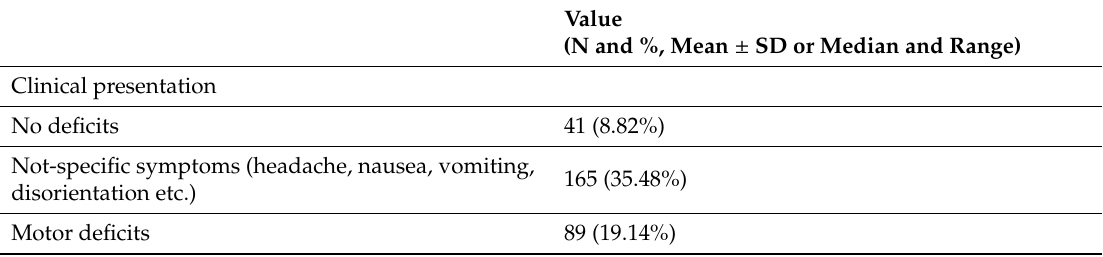
Table A2. Clinical and follow-up characteristics of the study